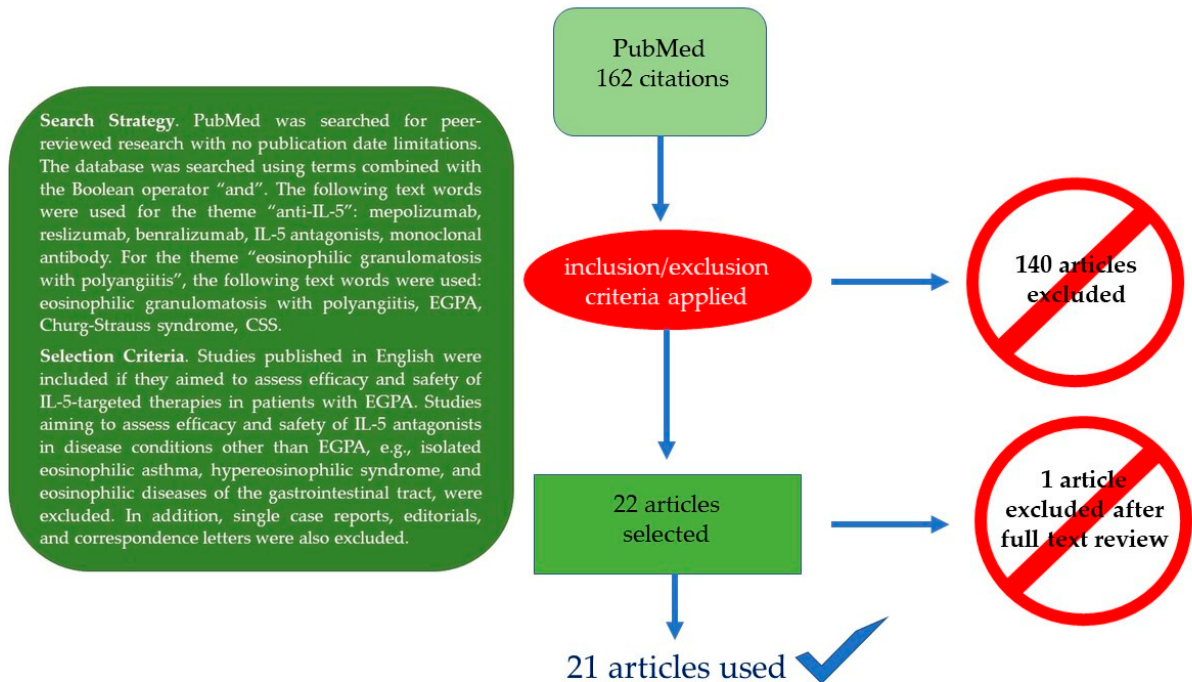
Figure 2. Literature search strategy (box) and final search outcome.